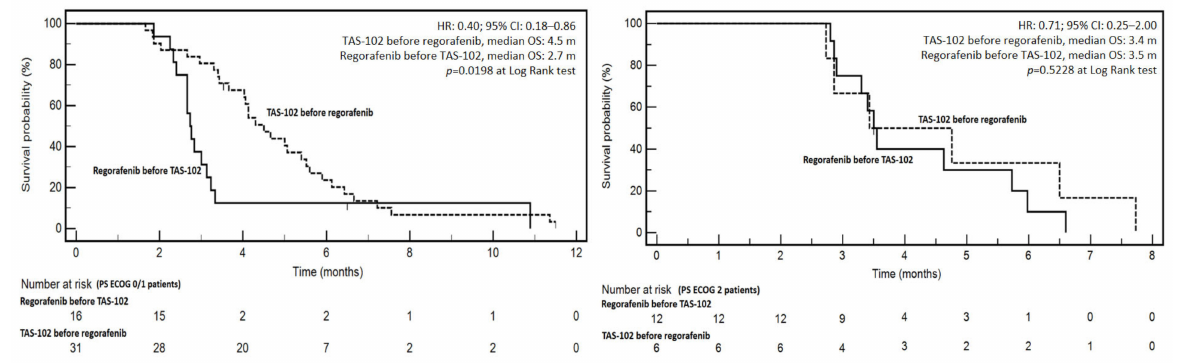
Figure 2. Kaplan–Meier survival curves according to TAS-102 first or regorafenib first in PS ECOG 0/1 (left side) or PS ECOG 2 patients (right